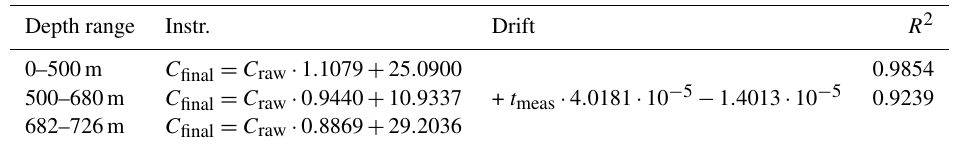
Table B1. Calibration of the RICE CFA methane data set is performed by comparison to the RICE discrete methane data set with corrections for instrument sensitivity and instrument drift. Calibration is done for different segments of the core. Quality of the fit is described by the R 2 statistic comparing calibrated values of the subsampled CFA methane record to discrete